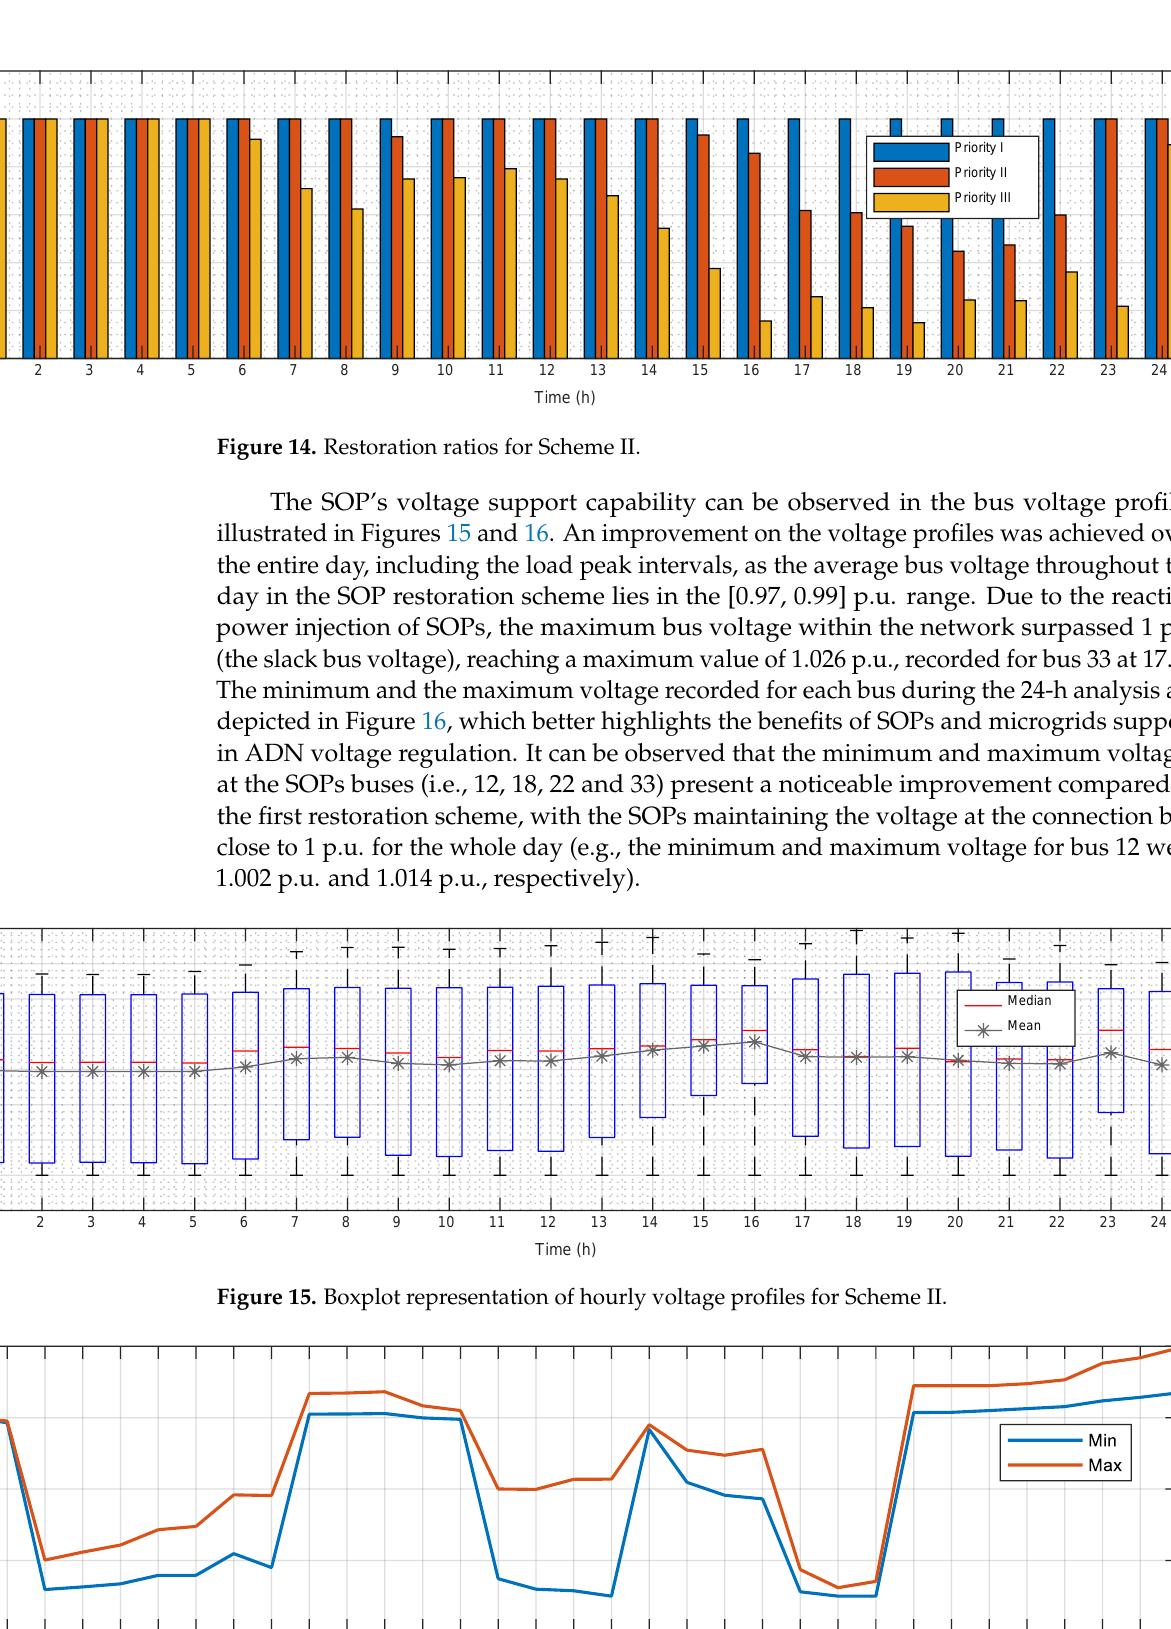
( b ) Figure 12. DC -microgrids scheduling for: ( a ) MG 1; and ( b ) MG 2. ( a ) ( b ) Figure 13. SOPs’ converters output: ( a ) active power; and ( b ) reactive power. To further analyze the influence of the SOP on the supply recovery, the restoration